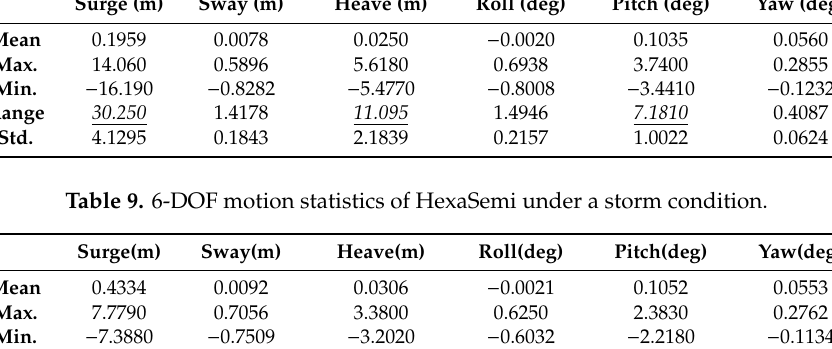
Table 9. 6-DOF motion statistics of HexaSemi under a storm condition.